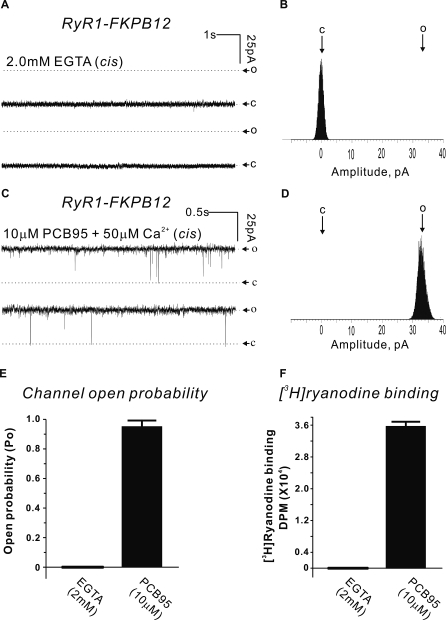
Creating Functionally Homogeneous Open and Closed Datasets of RyR1-FKBP12(A–E) Purified RyR1 channels were reconstituted in BLMs from a total of four independent junctional SR preparations. Once channels were fused and verified for activity, 2 mM EGTA (pCa2+ < 108) perfused into the cis chamber produced a fully closed state (C) with no gating transitions to the open state (O) as shown by the BLM traces and amplitude histogram of the representative channel (A and B). This behavior was observed in four of four channel reconstitutions (E). Pretreatment with PCB 95 (10 μM) persistently stabilized the full open state of RyR1 as shown by the representative channel (C and D). The cis solution contained 50 μM Ca2+, 10 μM PCB 95, and 100 nM FKBP12 throughout the recording. This behavior was observed in ten of ten reconstitutions (E) and lasted the duration of each recording (ranging between 12 s and 6 min).(F) [3H]ryanodine binding to RyR1 junctional SR vesicles in the presence of 2 mM EGTA show negligible specific high-affinity binding or in the presence of 50 μM free Ca2+ and 10 μM PCB 95 shows >3.5 × 104 dpm specific binding. The data summarize results from four independent measurements obtained from two different junctional SR preparations.